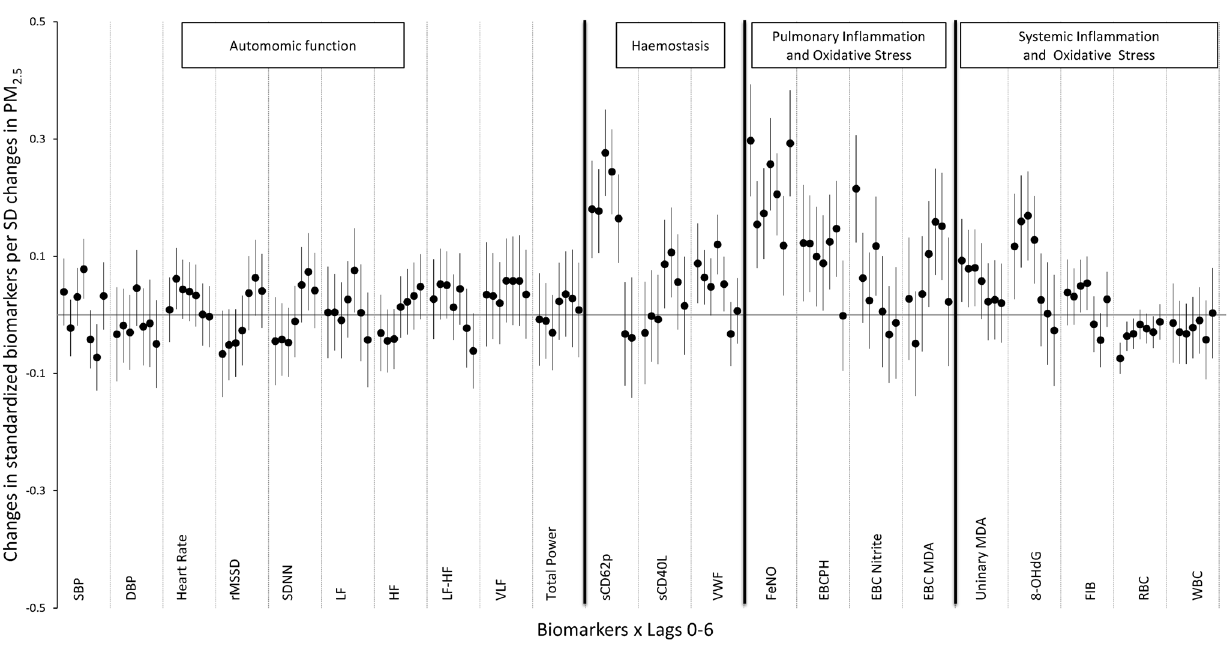
Fig. 2. Associations ( ^ b bpl ) between standardized 24 hour average ambient PM 2.5 concentrations and standardized biomarkers in each pathway, from Stage I models. Error bars represent 95% confidence intervals. Effect sizes are scaled to a 1 standard deviation change in PM 2.5 (51.9 m g/m3).